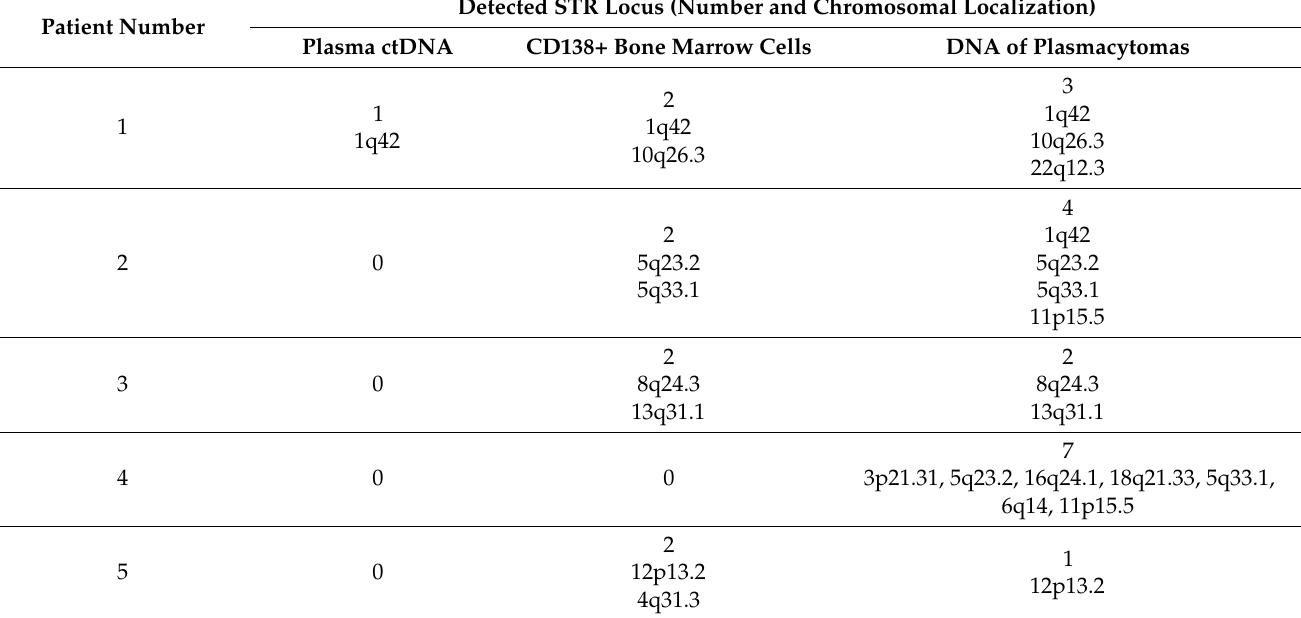
Table 6. Comparison of aberrant STR loci in tumors of different localizations in MM